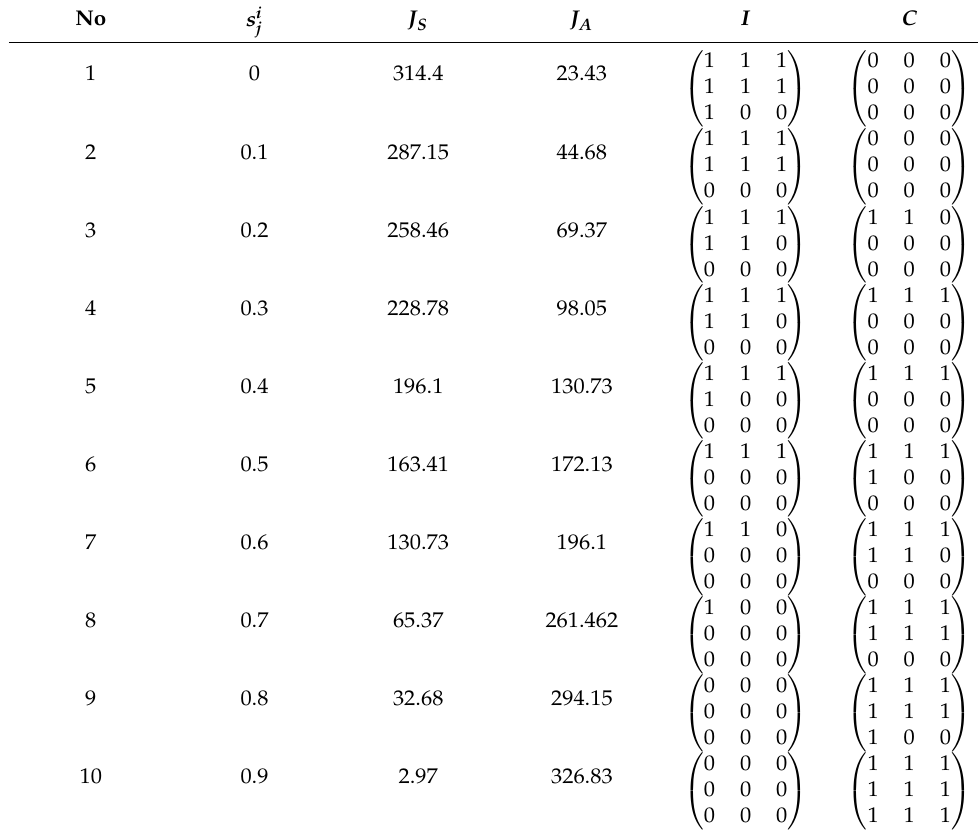
Table 5. Players’ optimal strategies and payoffs in dependence of the auctioneer share.